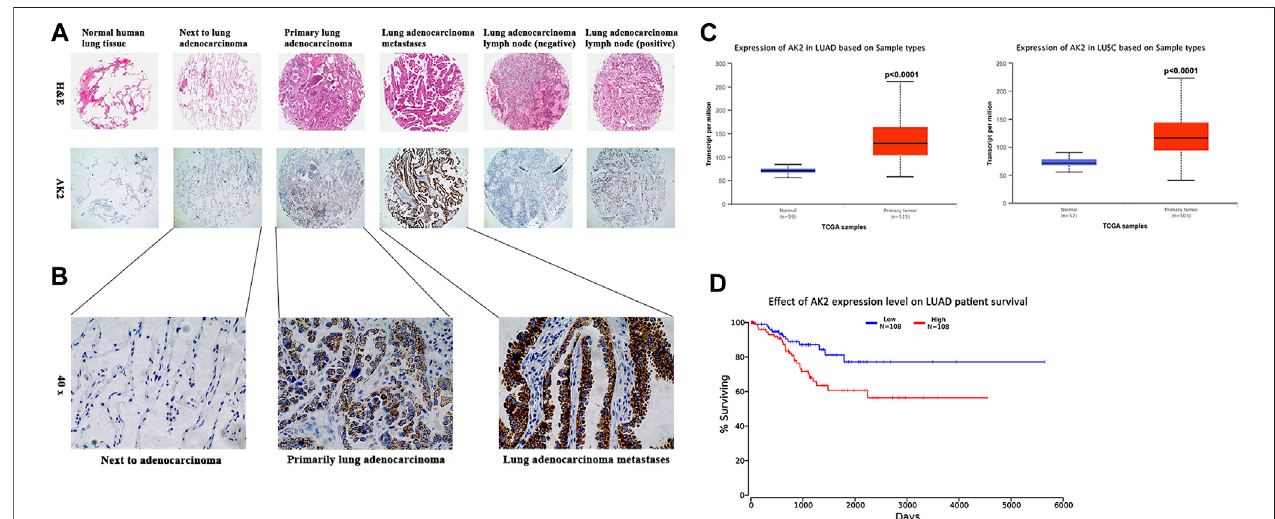
FIGURE1| AK2isup-regulatedinhumannon-smallcelllungcarcinomaandisassociatedwithpoorprognosis. (A) AK2expressionwasmeasuredbyH&Estaining (100 × )andimmunohistochemicalanalysis(100 × )onhumantissuemicroarrays.Representativeimageswereshown:normallungtissue,lungadenocarcinomaadjacent tissue, lung adenocarcinoma primary tumor, lung adenocarcinoma metastasis, lung adenocarcinoma lymph node (negative), and lung adenocarcinoma lymph node (positive). (B) Further magni fi edAK2 expression inparacancerous, primary and metastatic carcinomaoftheleftfrontal lobe(fromlung adenocarcinoma) inpatients with stage IV lung adenocarcinoma (200 × ). (C) Increased AK2 expression in Lung Adenocarcinoma (LUAD, left) and Lung Squamous cell Carcinoma (LUSC, right), analyzed in TCGA database separately. (D) Cancer survival analysis of AK2 expression in LUAD was assessed on Kaplan-Meier plotter. Meta-analysis based on biomarker assessment showed that high AK2 expression has a poor survival in human Lung adenocarcinoma. p -value is calculated using log-rank test.